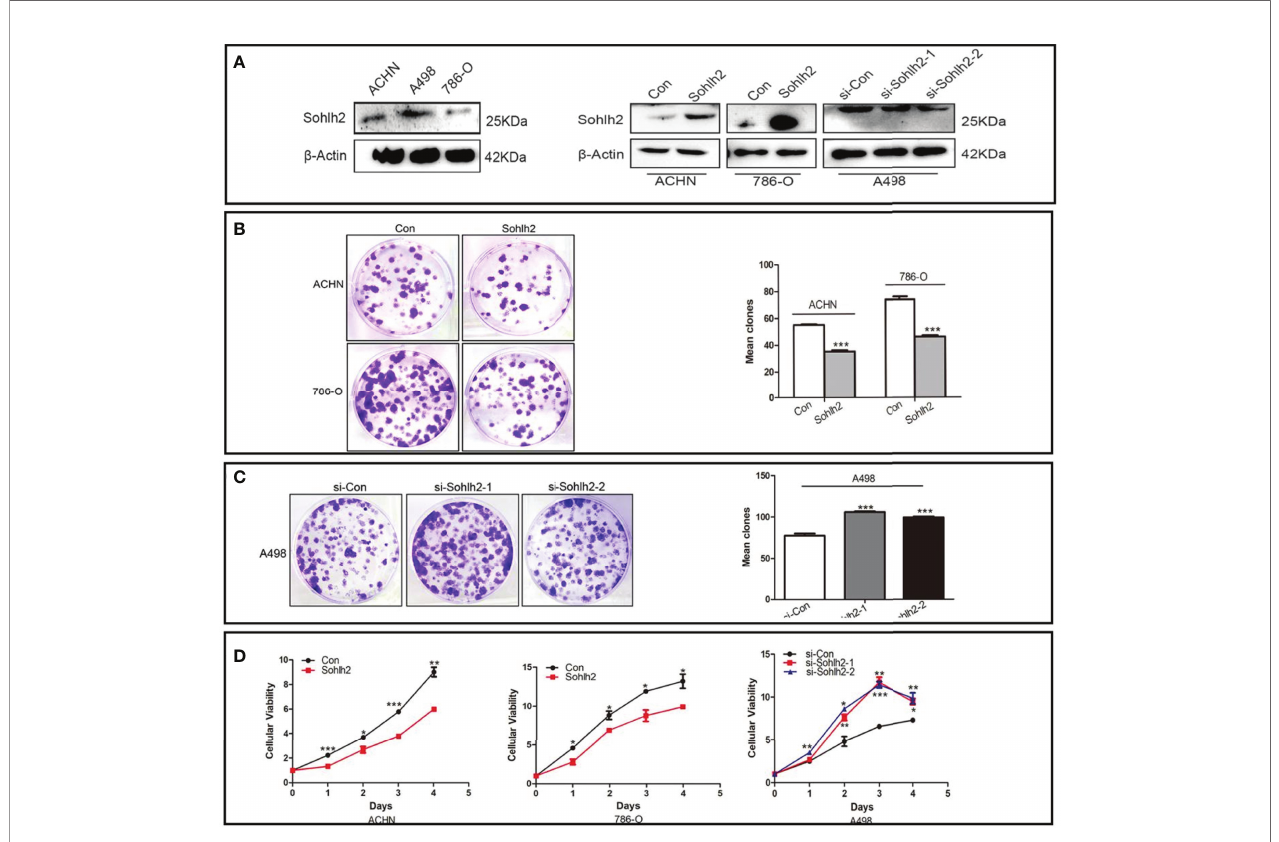
FIGURE 2 | Sohlh2 repressed proliferation of RCC cells in vitro . (A) The Western blotting results of Sohlh2 expression in 3 kinds of RCC cell lines (left) and the establishment of Sohlh2 overexpression and knockdown cell lines. (B) The result of the Sohlh2 overexpression group by colony formation. (C) The results of Sohlh2 knockdown groups. (D) CCK-8 assays were performed to analyze the proliferative difference between Sohlh2 overexpression and Sohlh2 knockdown groups. Statistical analysis was performed by GraphPad Prism 5. RCC, renal cell carcinoma; CCK-8, Cell Counting Kit-8. (*P < 0.05; **P < 0.001; ***P <